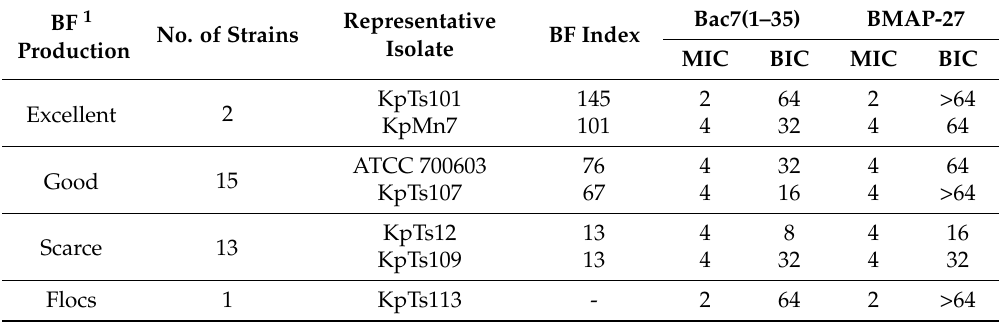
Table 1. Biofilm production and susceptibility to antimicrobial peptides (AMPs) of K. pneumoniae strains. BF